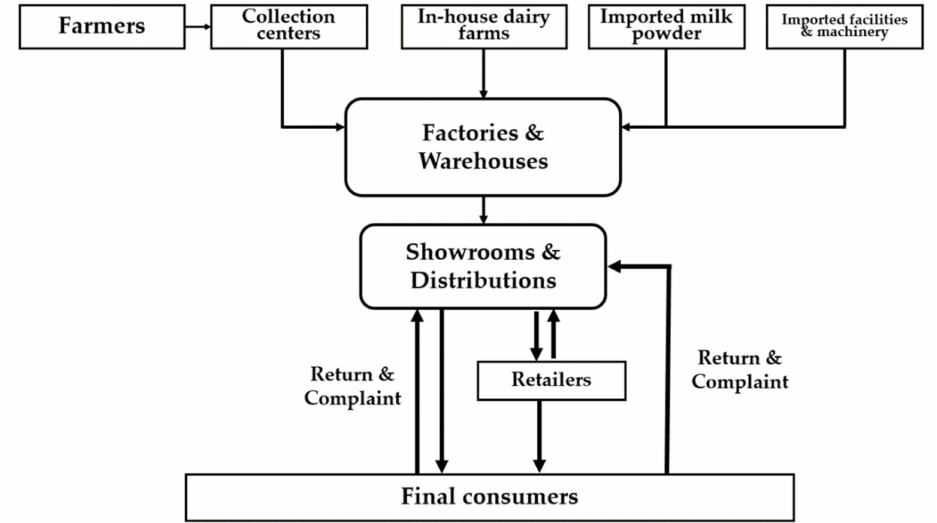
Figure 1. Simplified Vietnam’s Dairy Supply Chain. (Source: The authors).